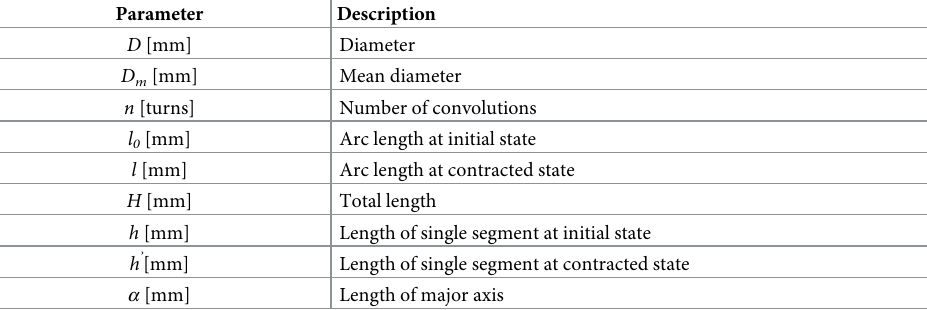
Table 1. Nomenclature of the bellow skin.